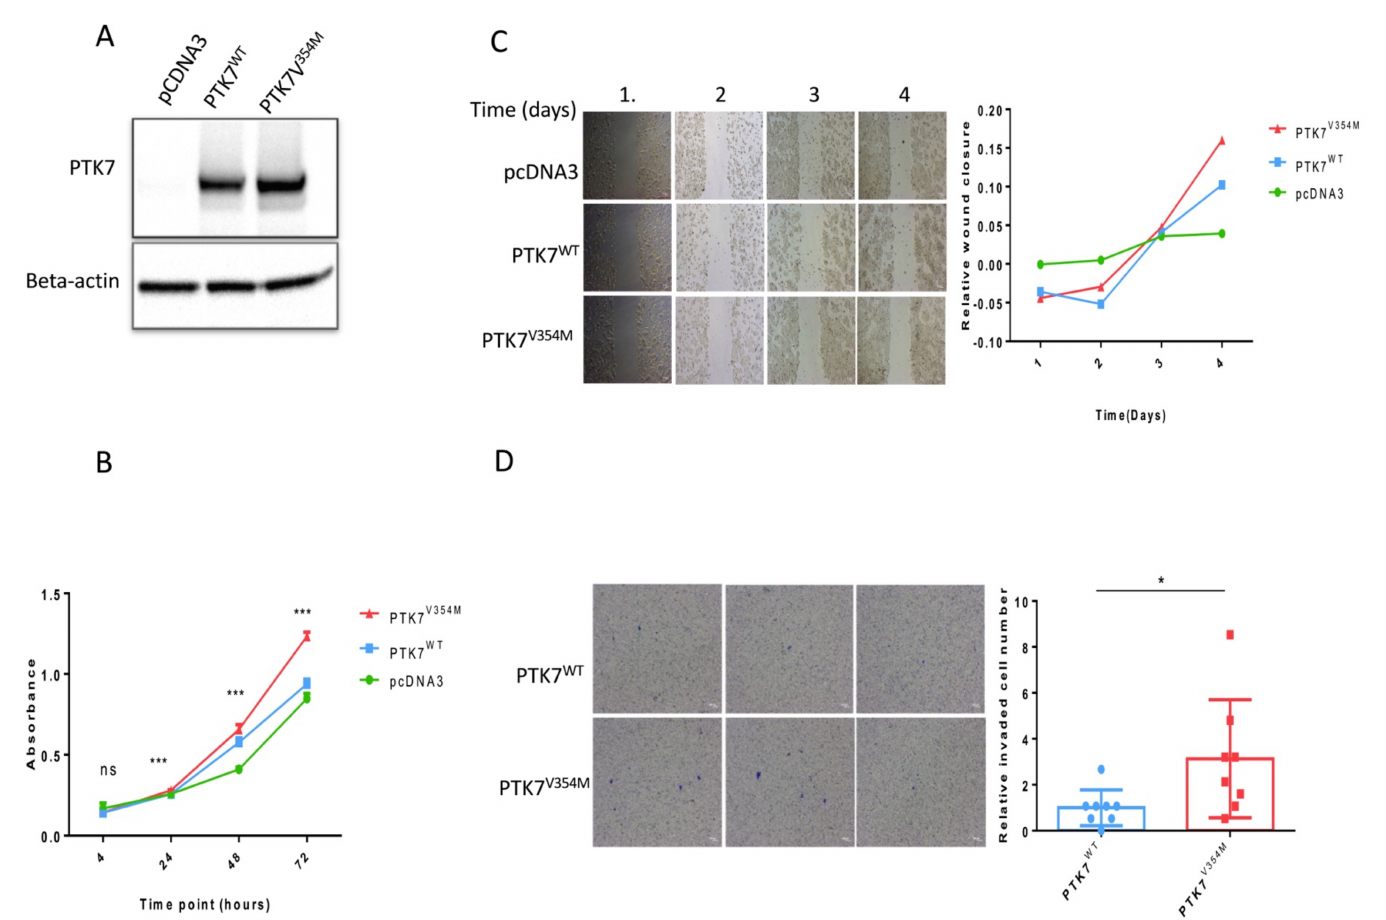
Figure 3. PTK7 V354M variant increases cell proliferation, migration, and invasion. ( A ) Western blot results represent enhanced protein expression of PTK7 in HT29- PTK7 V354M cells compared to HT29- PTK7 WT cells. ( B ) Proliferation assays show significantly increased viable cell numbers of HT29- PTK7 V354M compared to HT29- PTK7 WT cells. Significance levels are included for each time point. ns—no significance, *** p < 0.001. ( C ) Representative image of migrated HT-29 cells after overexpression of PTK7 WT and PTK7 V354M . ( D ) Representative image of invaded HT-29 cells after overexpression of PTK7 WT and PTK7 V354M . * p < 0.05. PTK7 V354M –PTK7 plasmid with the mutation V354M, PTK7 WT –wild type PTK7 plasmid, pcDNA3–control vector